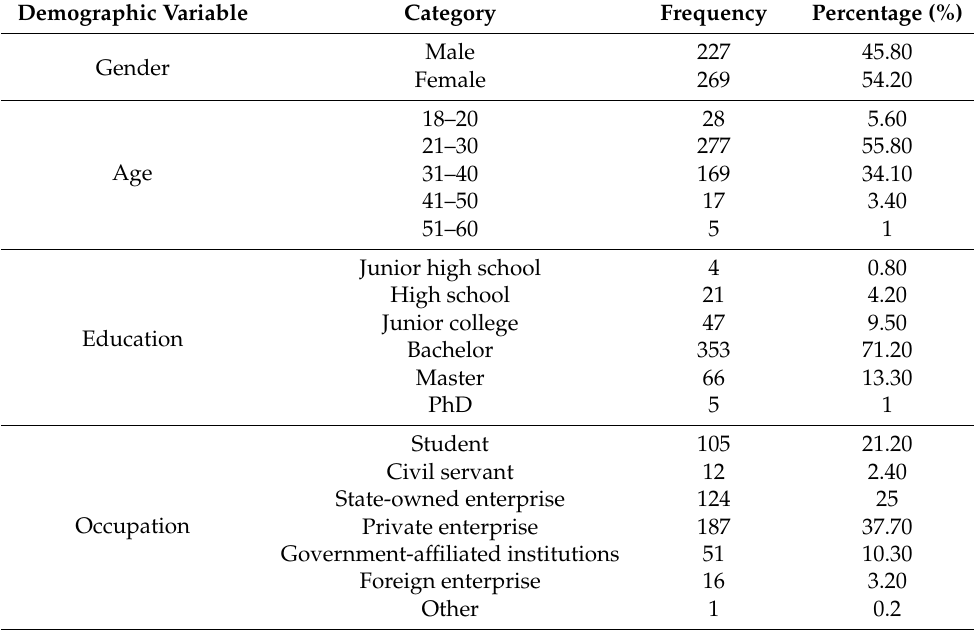
Table 1. Demographic characteristics of the sample (N =